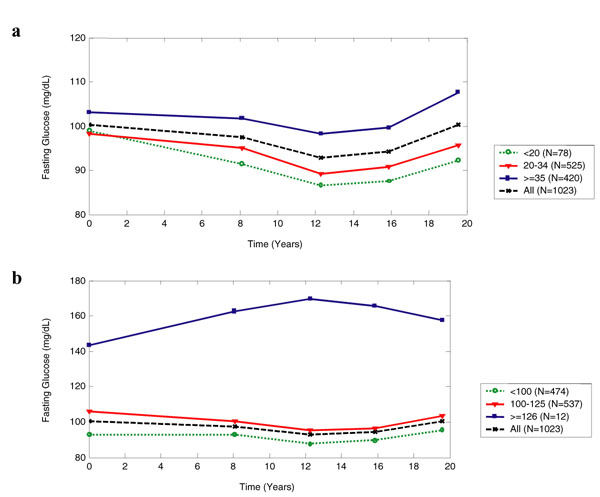
Exploratory analysis of change in fasting glucose a. Change in levels of mean fasting glucose when stratified by age at baseline. At baseline, the mean ages of grouped subjects were approximately 16 years for G1, 27 years for G2, and 43 years for G3, respectively. The mean of the fasting glucose levels over the five time points was 91.33 mg/dl in G1, 93.82 mg/dl in G2, and 102.06 mg/dl in G3, respectively. b. Change in mean fasting glucose levels stratified by initial levels.Fasting glucose levels were grouped at baseline as <100 mg/dl, 100–125 mg/dl, ≥ 126 mg/dl, and followed over all five time points.